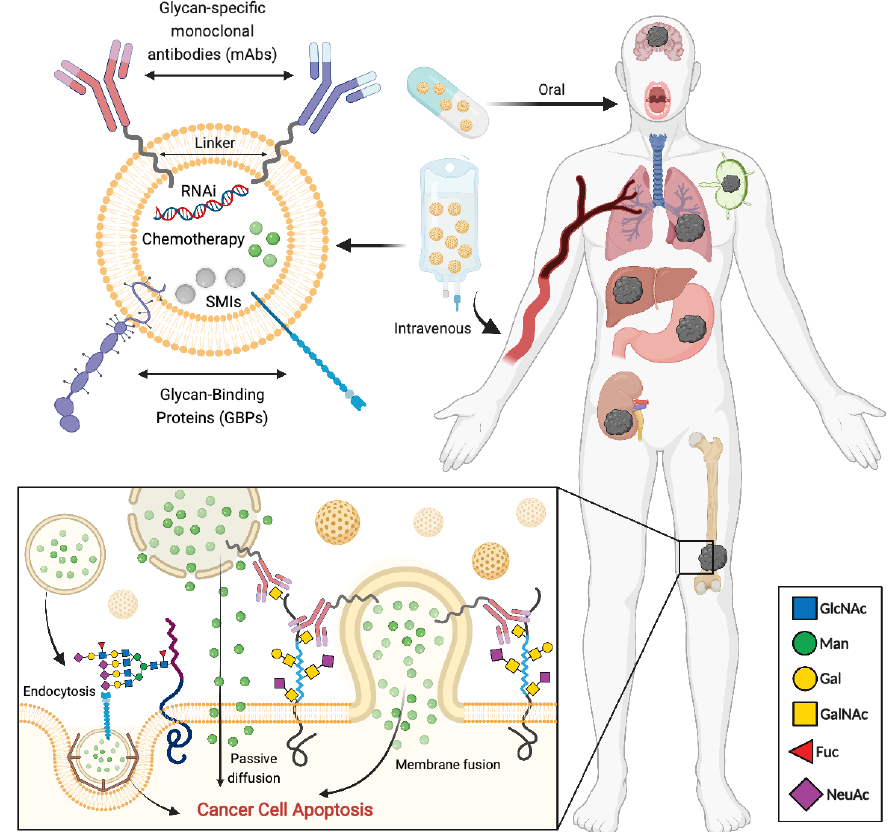
Figure 2. Strategies based on targeting cancer-associated glycans for selective and specific drug de- livery